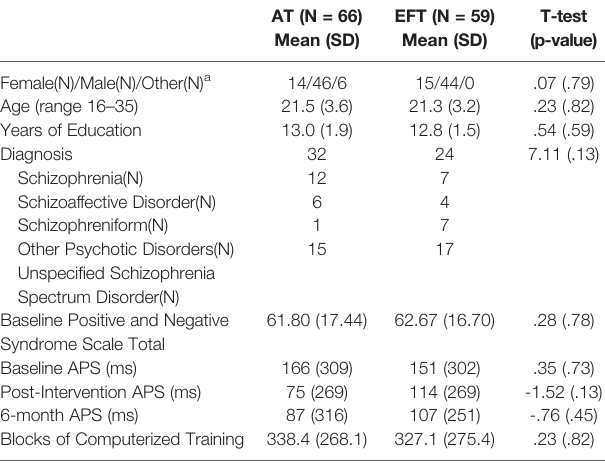
TABLE 1 | Demographics of participants randomized to Auditory Training (AT) and Executive Functioning Training